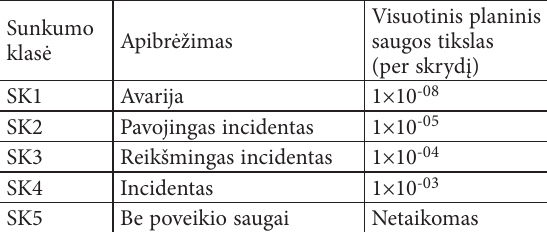
Table 1. General (ATM) system risk classification scheme